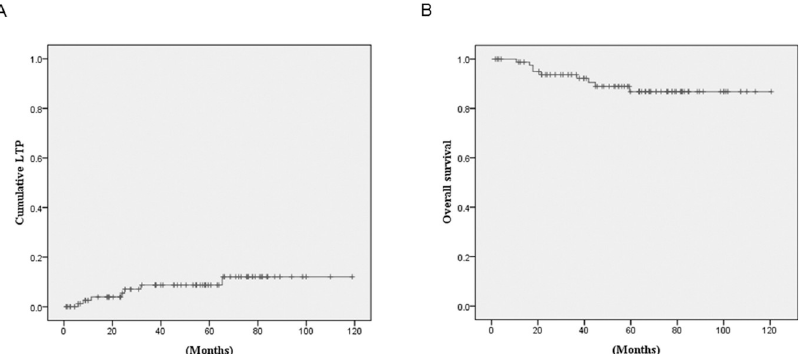
Fig 5. Cumulative local tumor progression rate and overall survival rate curves. (a) Cumulative local tumor progression rates in the overall data. (b) Overall survival rates in the overall data. LTP = local tumor progression.